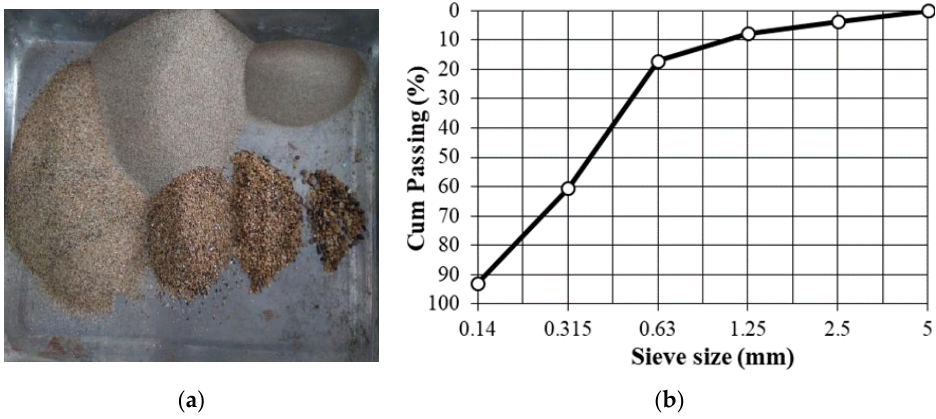
Figure 3. ( a ) Natural fine aggregate used and ( b ) its particle size distribution.